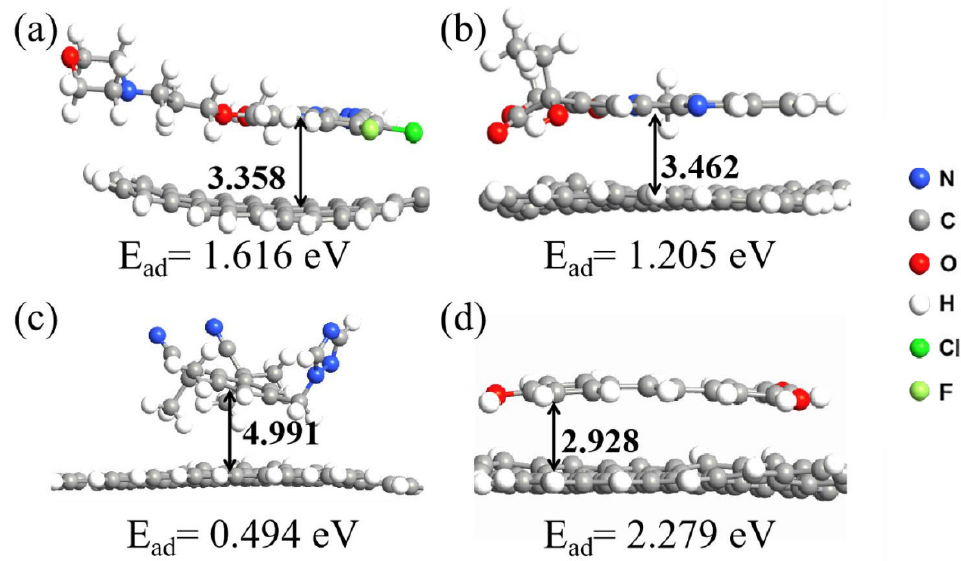
Figure 2. Optimized geometries of RGO and drug systems; bonds are in Å (the vertical distance refers to the distance between the centroid of benzene of different drugs to the carbon plane of RGO). ( a ) Graphene-Gefi; ( b ) Graphene-Camptothecin; ( c ) Graphene-Anas; ( d ) Graphene-Res.